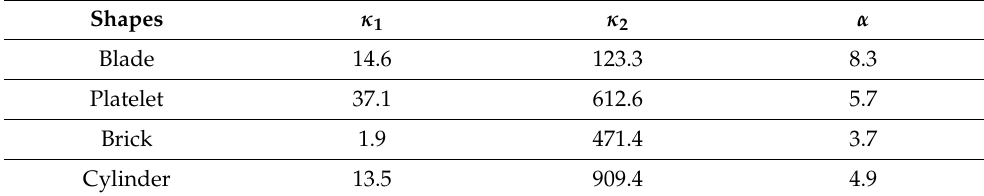
Table 1. Values of α , κ 1 , and κ 2 for multiple shapes of nanoparticles [42]. Shapes κ